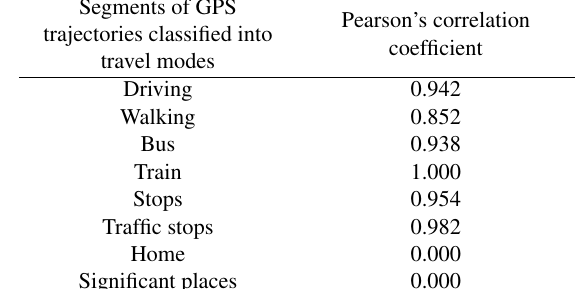
Table 2: Pearson’s correlation coefficients for various travel modes. The results are based on the sample of 5 individuals.